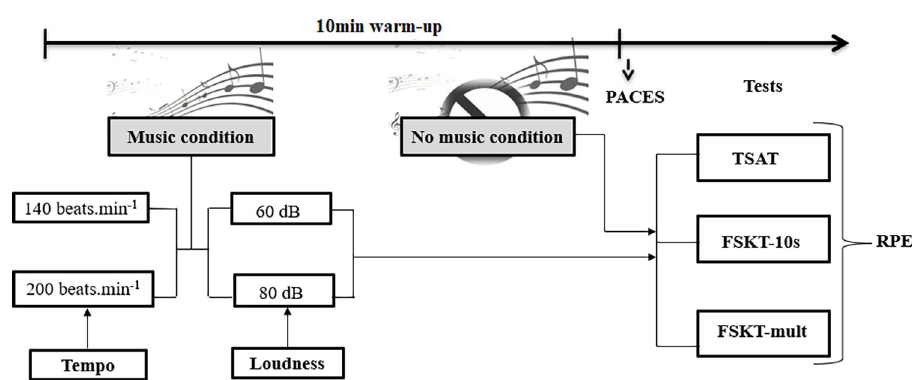
Fig 1. Schematic representation of the study design. PACES: Physical Activity Enjoyment Scale; RPE: Rating of perceived exertion; TSAT: taekwondo specific agility test; FSKT-10s: 10s frequency speed of kick test; FSKT-mult: multiple frequency speed of kick